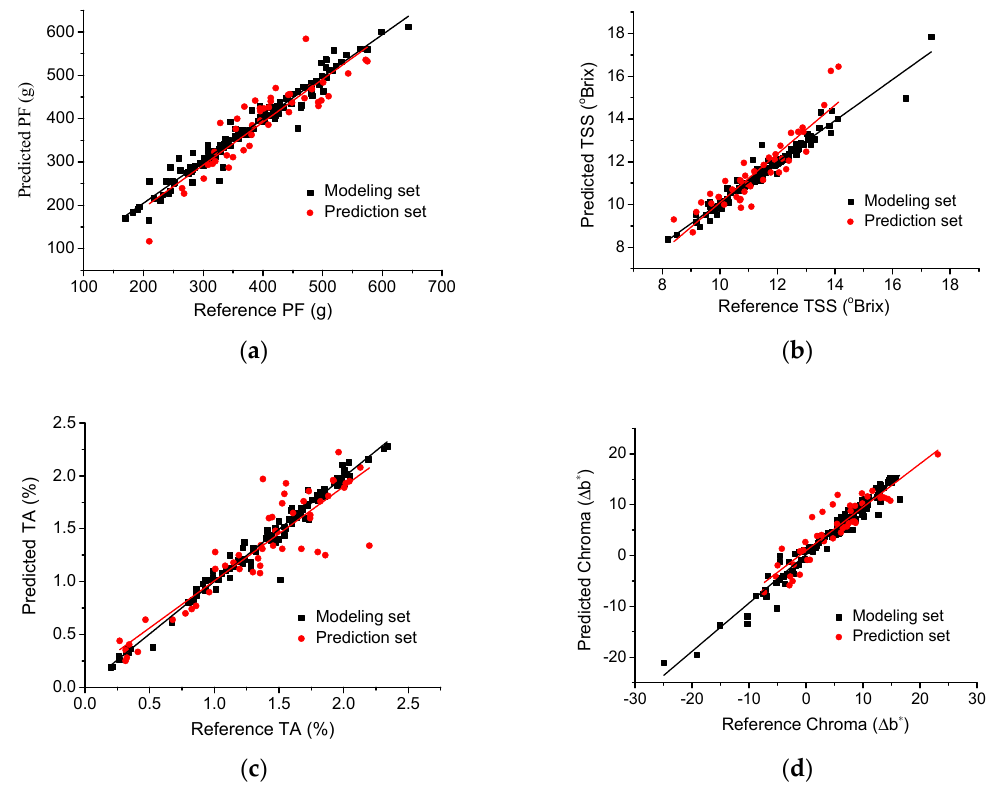
Figure 6. Scatter plots of predicted and reference quality attributes from both modeling sets and prediction sets for ( a ) pulp firmness (PF); ( b ) total soluble solids (TSS); ( c ) titratable acidity (TA) and ( d ) chroma ( ∆ b*)